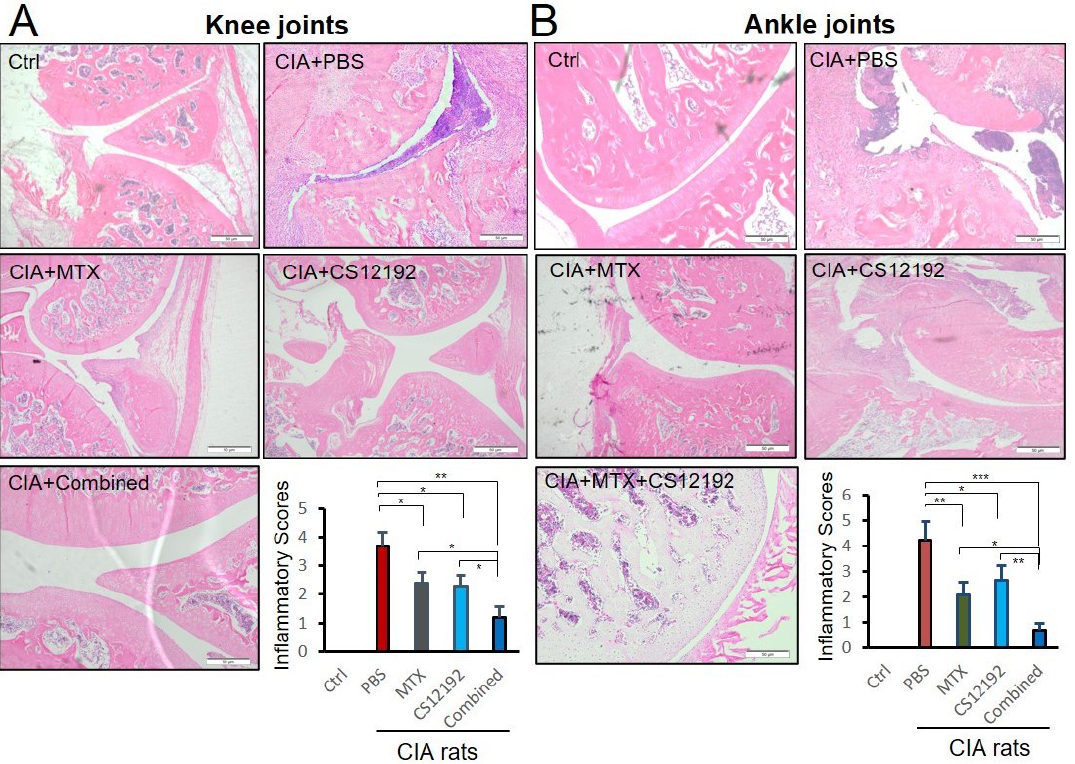
Figure 2. Therapeutic effects of MTX, CS12192, or the combination of CS12192 and MTX on joint histopathology of CIA rats. ( A ) knee and ( B ) ankle joint tissue sections of CIA rats in different groups by Hematoxylin and Eosin staining. Scale bar = 50 µ m. Inflammation scores were calculated as described in the Methods. Data represent the mean ± SEM for groups of 10 rats from different groups. * p < 0.05; ** p < 0.01; and *** p < 0.001 as